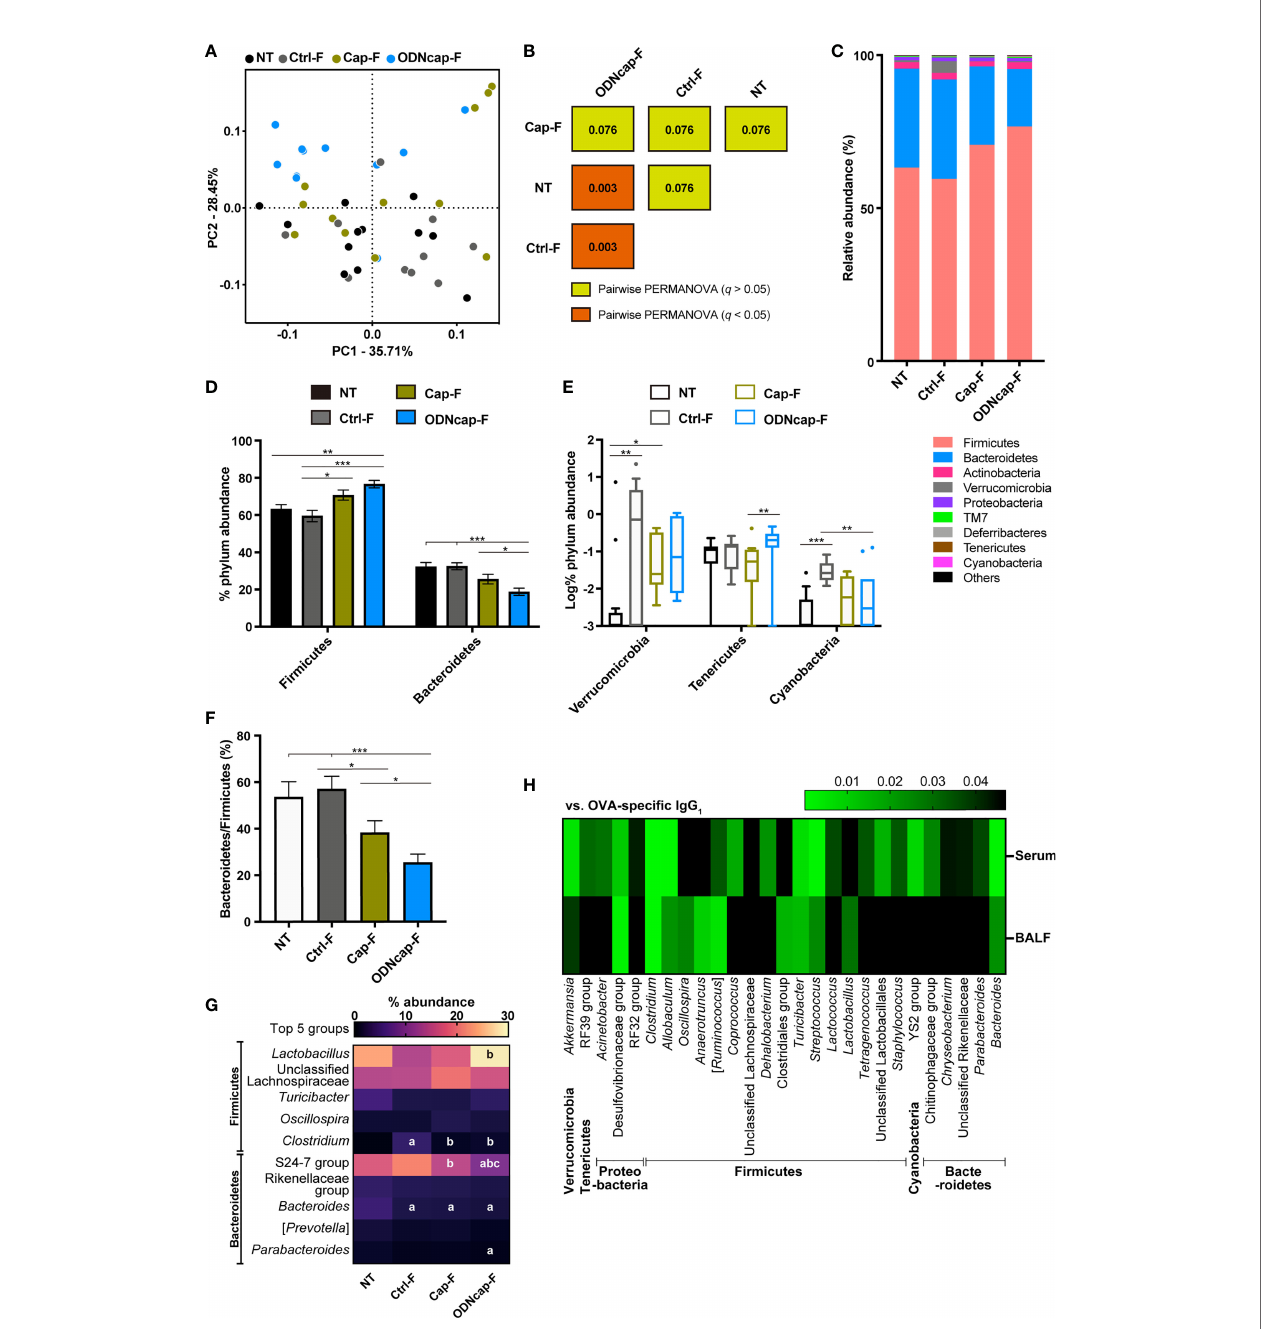
FIGURE 8 | ODNcap-F alters the structure and composition of the fecal microbiota. Feces were collected on Day 70. The V3 – V4 regions of 16S rRNA genes were ampli fi ed from fecal DNA and subjected to next-generation sequencing ( n = 12). The data were processed and analyzed using the QIIME2 pipeline. (A) Two- dimensional plot of the weighted UniFrac-based principal coordinate analysis of the microbiome. (B) Results of pairwise permutational multivariate analysis of variance (PERMANOVA) based on weighted UniFrac distances are visualized. Values in the boxes indicate q , which is an adjusted P value. (C – E) Phylum-level composition (proportional abundance) of the microbiota in each group. (F) Bacteroidetes to Firmicutes ratio. (C) Bars on the graph indicate means. (D, F) Data are shown as the mean ± standard error of the mean. *** P < 0.001; ** P < 0.01; * P < 0.05 by two-tailed one-way analysis of variance (ANOVA) and post hoc Tukey ’ s tests. (E) Data are shown as Tukey ’ s box plots. *** P < 0.001; ** P < 0.01; * P < 0.05 by two-tailed Kruskal – Wallis test with post hoc Dunn ’ s multiple comparisons. (G) Heatmap showing the mean values of proportional-relative abundance of the top fi ve groups belonging to the Bacteroidetes or Firmicutes phylum. Letters in the boxes represent signi fi cant differences; a, vs. NT; b, vs. Ctrl-F; c, vs. Cap-F ( P < 0.05 by two-tailed one-way ANOVA and post hoc Tukey ’ s tests). (H) Heatmap shows P -values of Spearman ’ s correlation between ovalbumin-speci fi c immunoglobulin G 1 (IgG 1 ) levels in serum or bronchoalveolar lavage fl uid (BALF) and the proportional relative abundance of the fecal bacterial